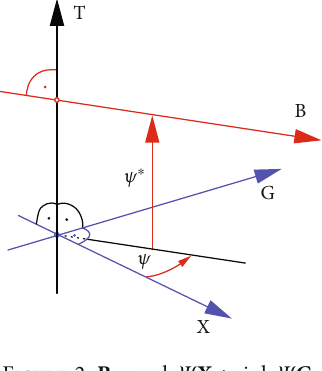
Figure 2: B = cosh Ψ X + sinh Ψ G :